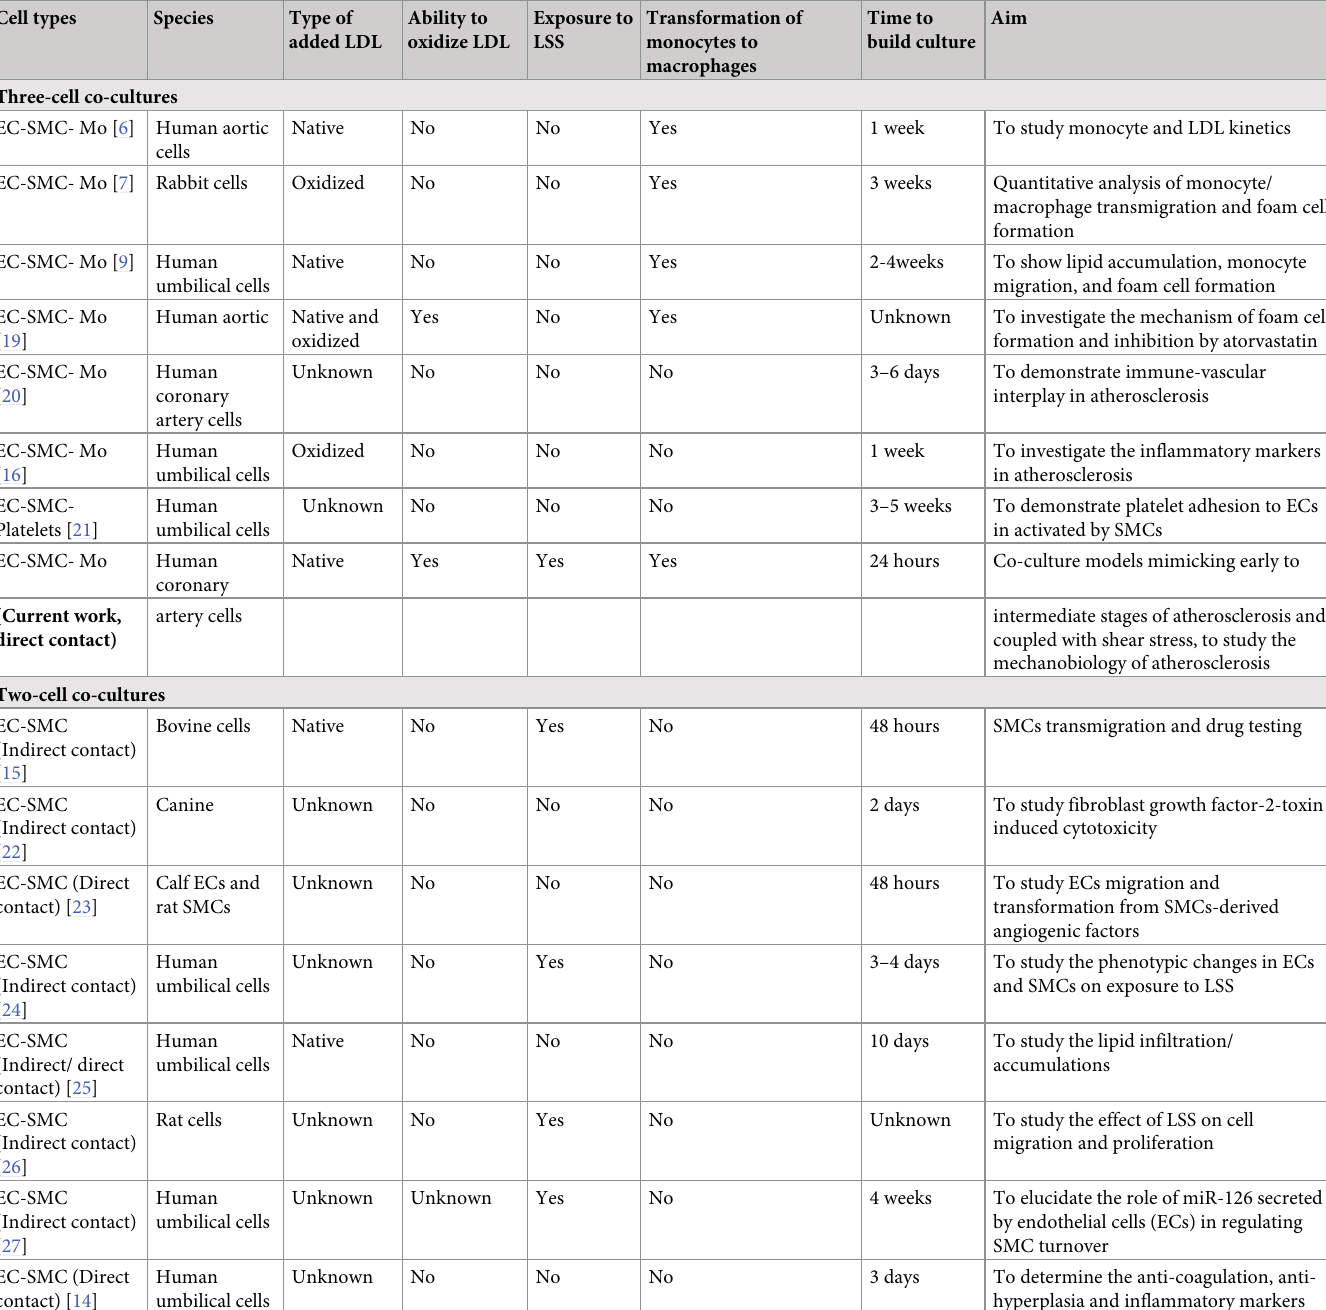
Table 2. Qualitative comparison of two- and three-cell co-culture models of atherosclerosis. Cell